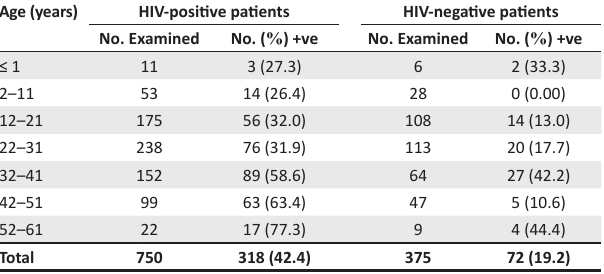
TABLE 1a: Prevalence of Microsporidiasis by age amongst HIV-positive and -negative patients ( n = 1125). Age (years) HIV-positive patients